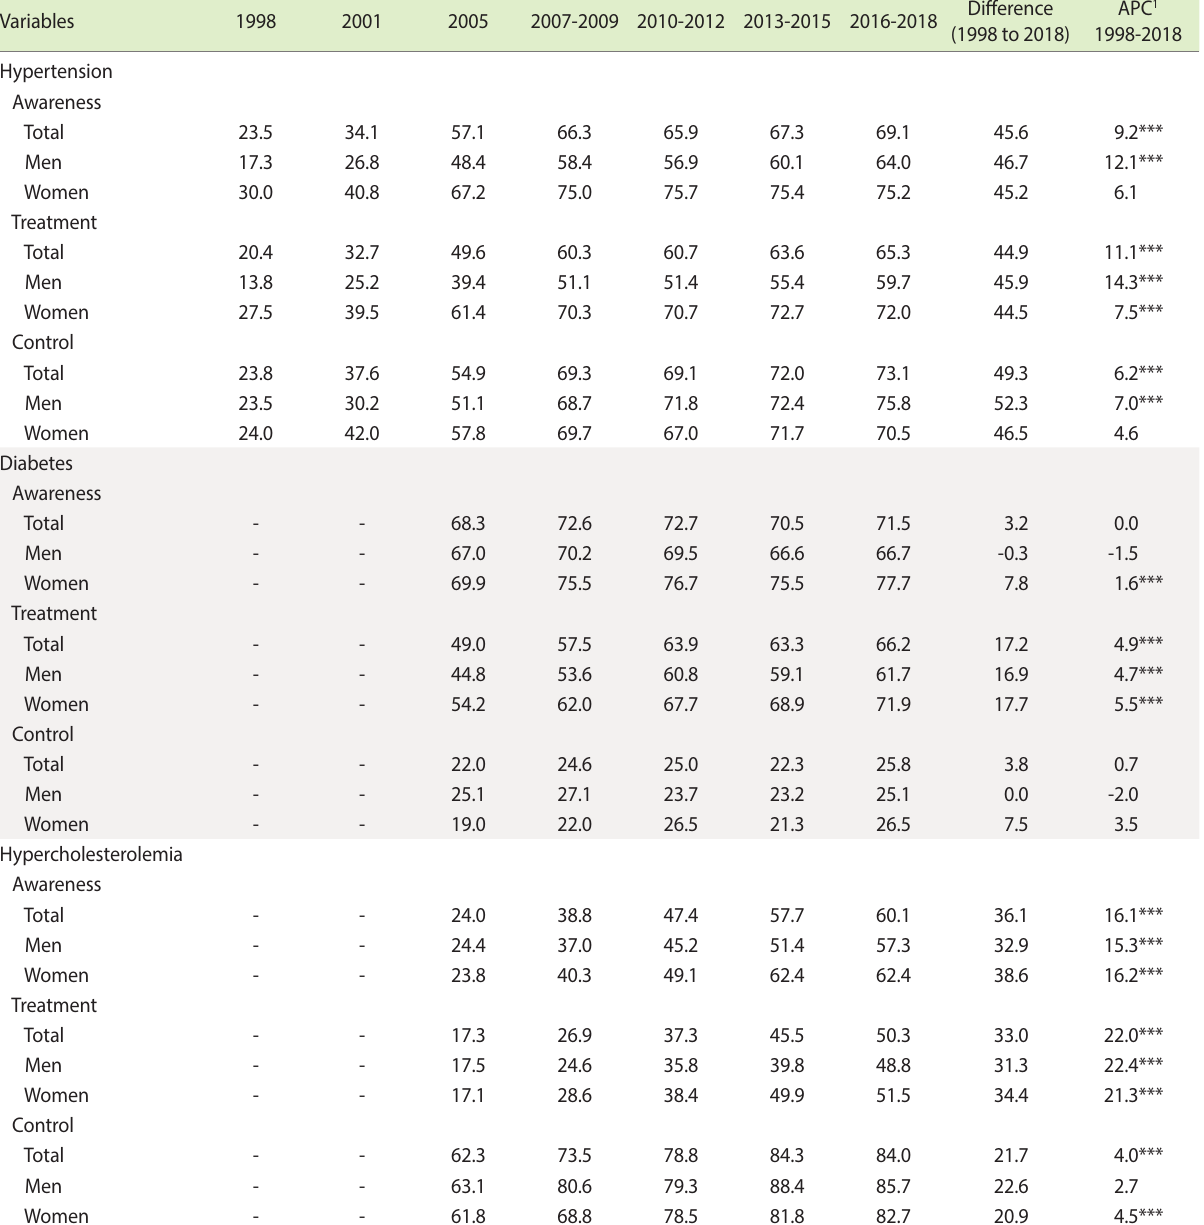
Table 4. Trends in the awareness, treatment, and control rates of hypertension, diabetes, and hypercholesterolemia among Koreans aged ≥30 years